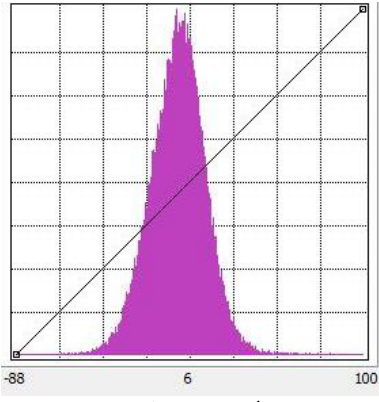
Figure 10. The histogram of the errors (30m resolution) Figure 11 shows the slope map of the research area derived from the UAV DEM (30m resolution). It can be seen that the slopes of most areas are greater than 30 degrees.